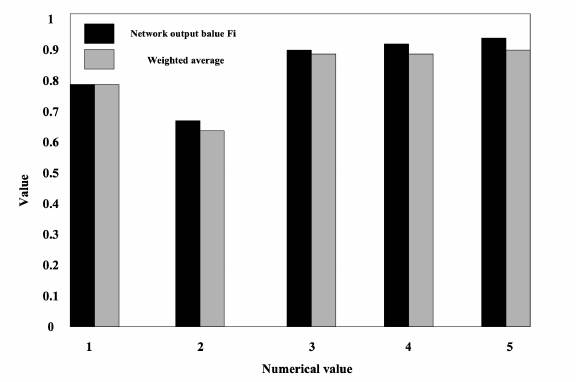
Fig. 4. COMPARISON OF BP NEURAL NETWORK OUTPUT AND WEIGHTED